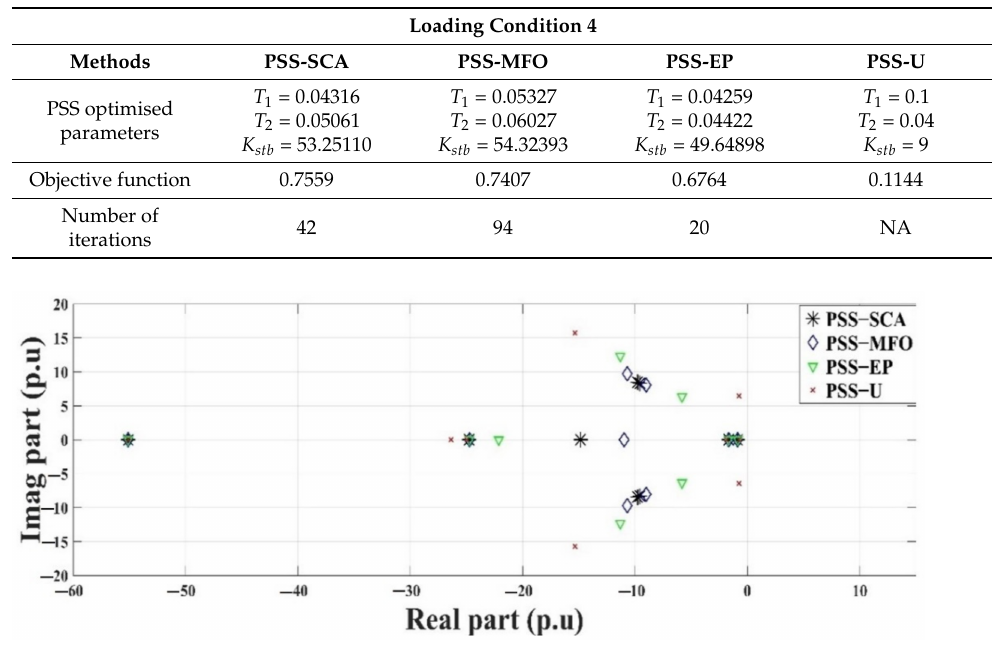
Figure 11. Rotor angle deviation for loading condition 3 of the SMIB with PSS. Table 10. Comparison of the PSS optimised parameters, eigenvalues, damping factor and damping ratio for loading condition 4 of the SMIB.